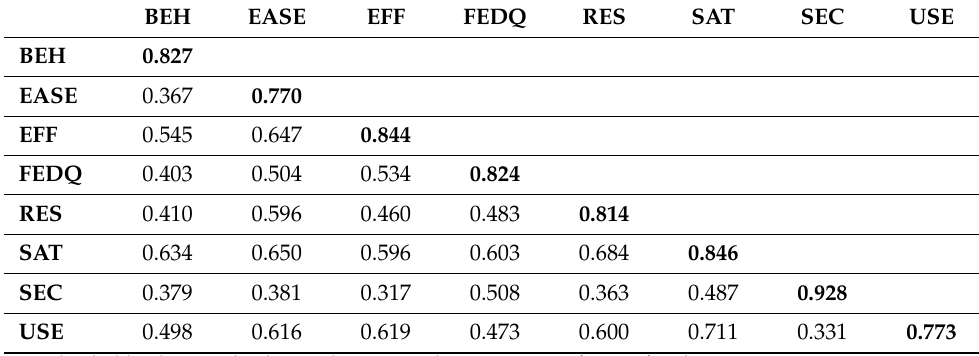
Table 3. Fornell–Larcker